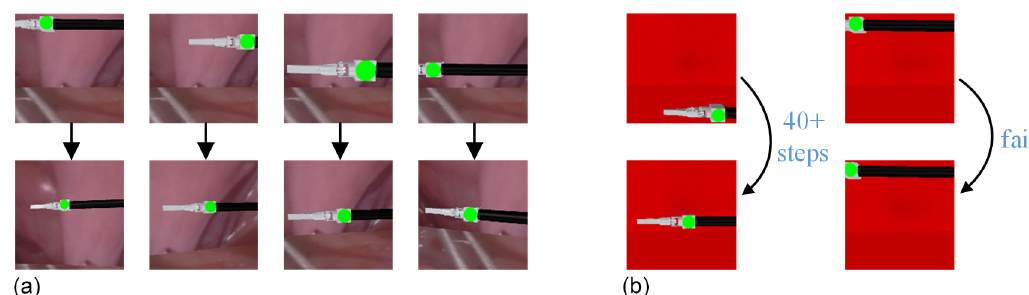
Figure 12. Visualization of test results. (a) Different pose testings of the surgical instrument. (b) Results of mission